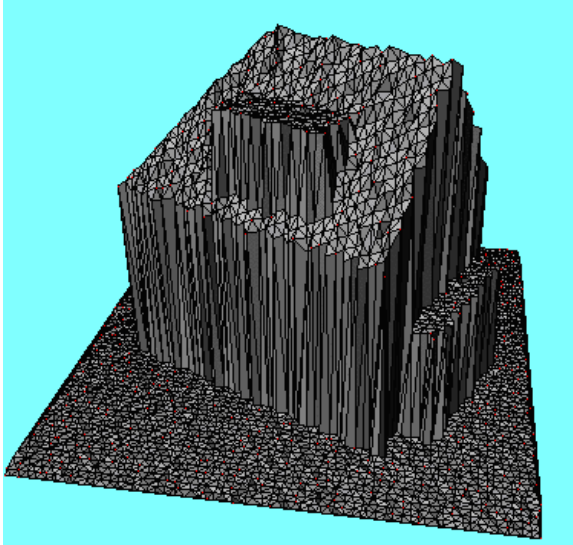
Figure 1. 3D view of a 2D Delaunay TIN of a simulated point cloud of a simple building.